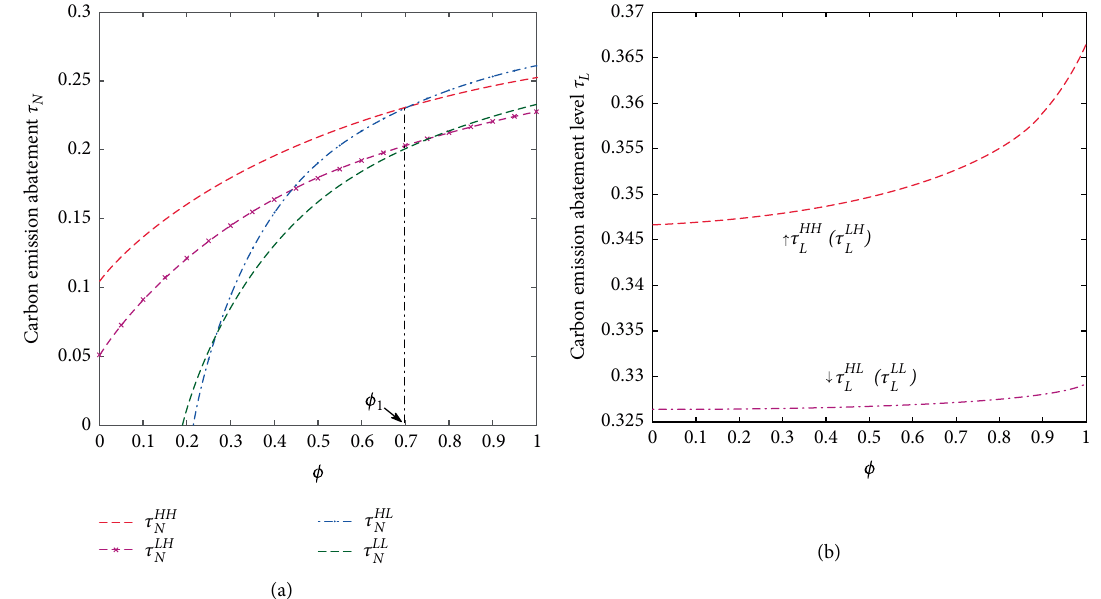
Figure 7: (a) Impact of 𝜙 on 𝜏